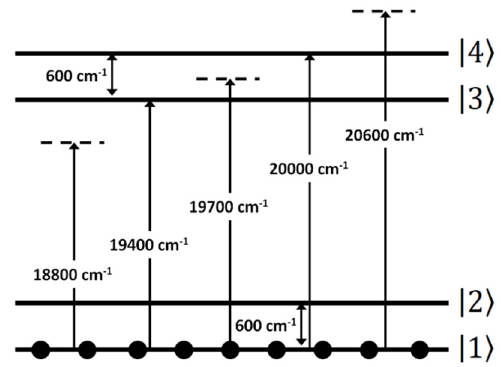
Figure 1. Schematic of the four level system showing the transition wavenumbers considered and different excitation frequencies.